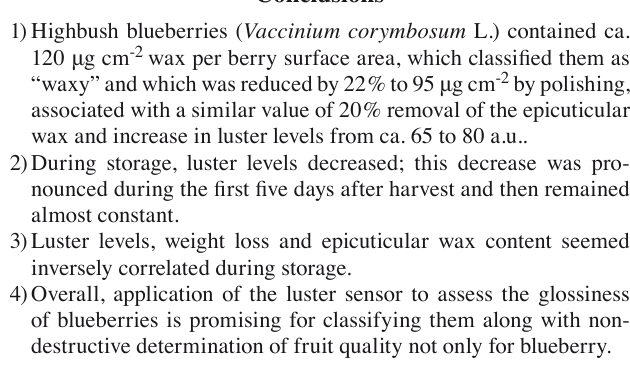
Fig. 3: Wax content (left; n = 3 of 25 berries each) and luster levels (right; n = 25) of polished (orange) and unpolished (blue) natural blueberries (mean and SDs − standard deviation).